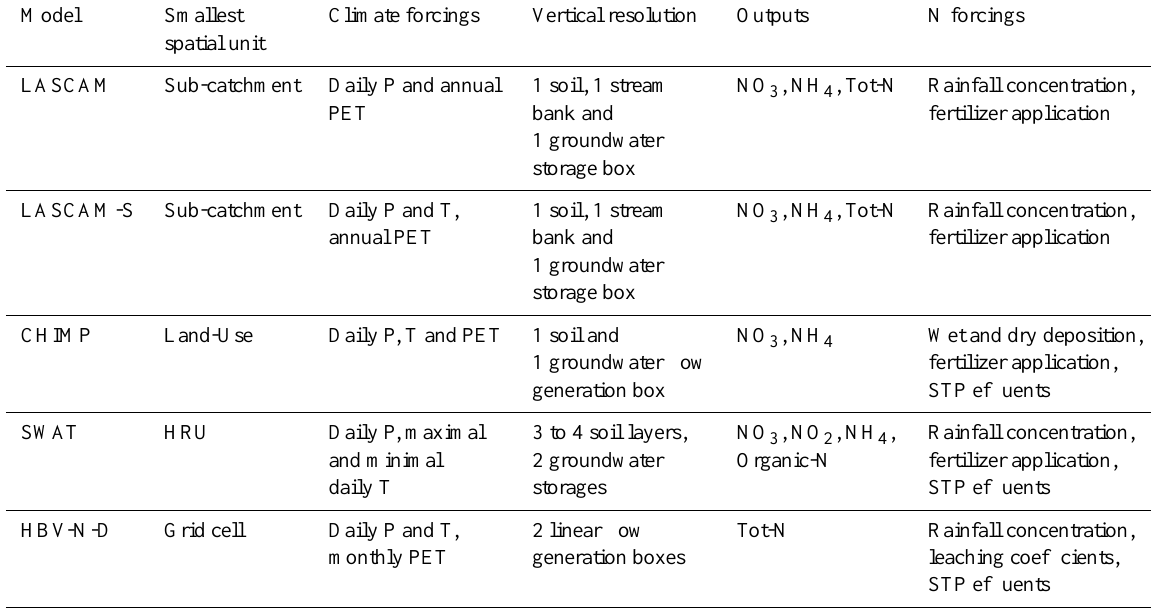
Table 1. Main model characteristics. Outputs are either N loads or